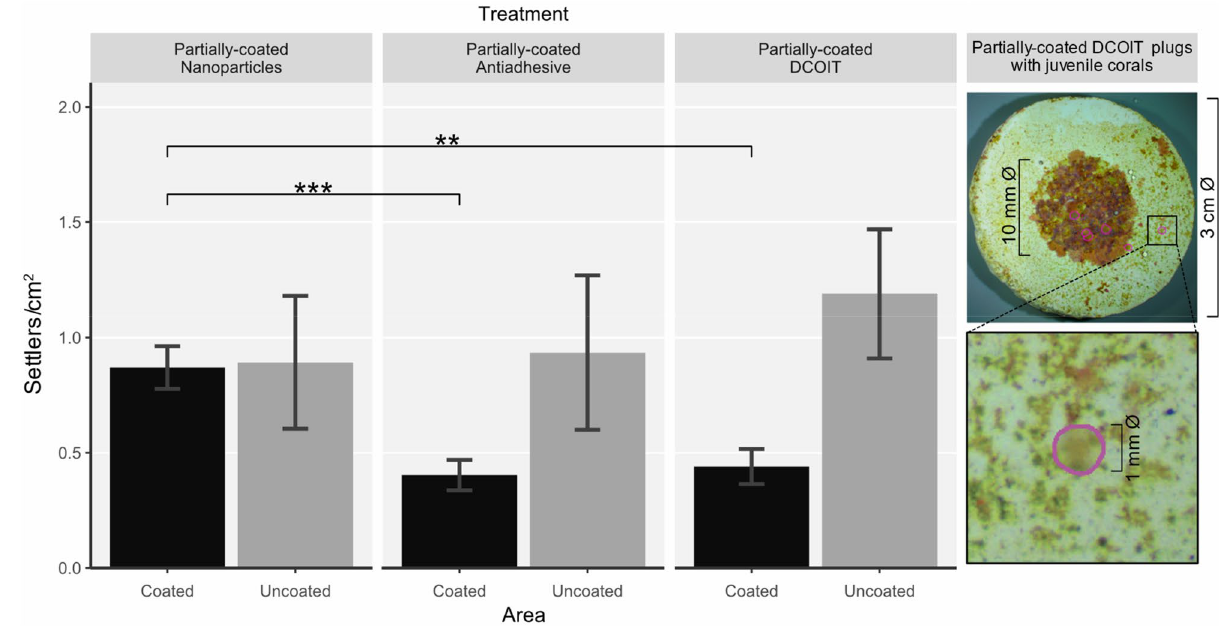
Figure 5. Pre-conditioned partially-coated (PC) plugs (Nanoparticles, Antiadhesive, DCOIT) with coated and uncoated areas (n = 30 plugs per treatment) were tested for mean coral larval settlement (settlers per cm 2 ) in individual glass jars (one plug with 15 larvae per jar). Error bars represent SEM. Asterisks indicate statistically significant differences based on pairwise post-hoc tests with estimated marginal means (Supplementary Tables S12 and S14; *p < 0.05, **p < 0.01, ***p < 0.001). Images (right) show coral settlers (circled in magenta) on a PC DCOIT